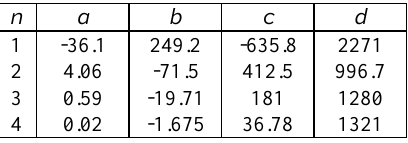
Table 2. Coefficients for fitted intensity-range function The correction method is applied to the original intensity data.